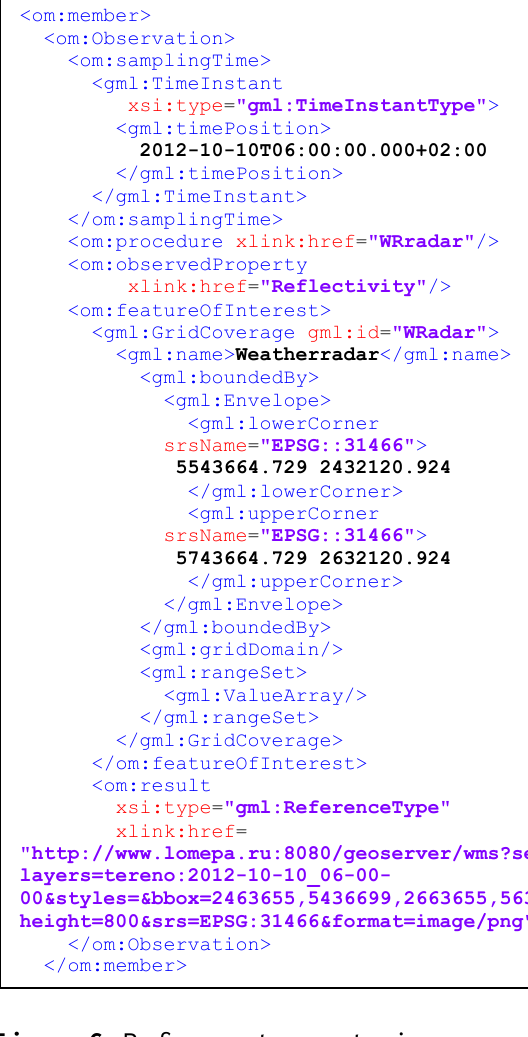
Figure 6. Reference to a raster image provided by a WMS and encoded with a generic O&M